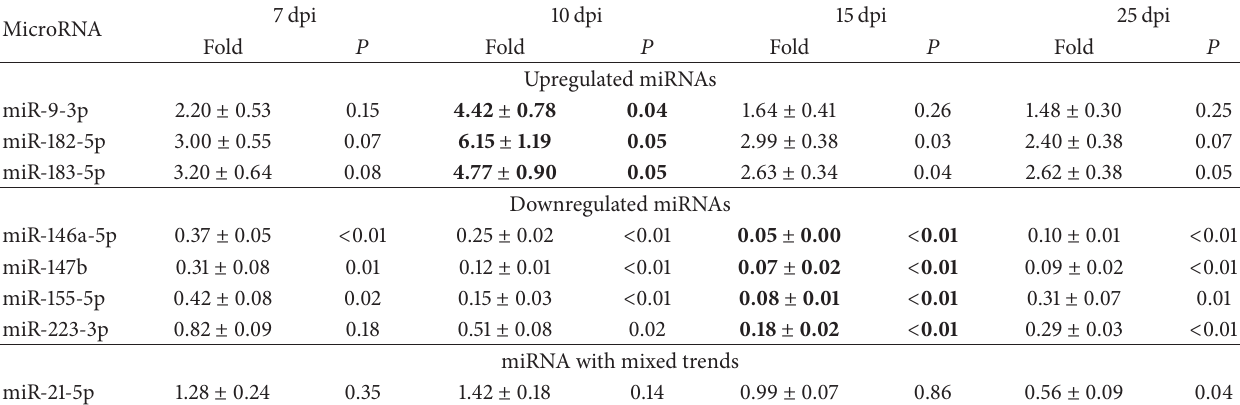
Table 1: Detailed microRNA expression profiles over the course of EAAU.